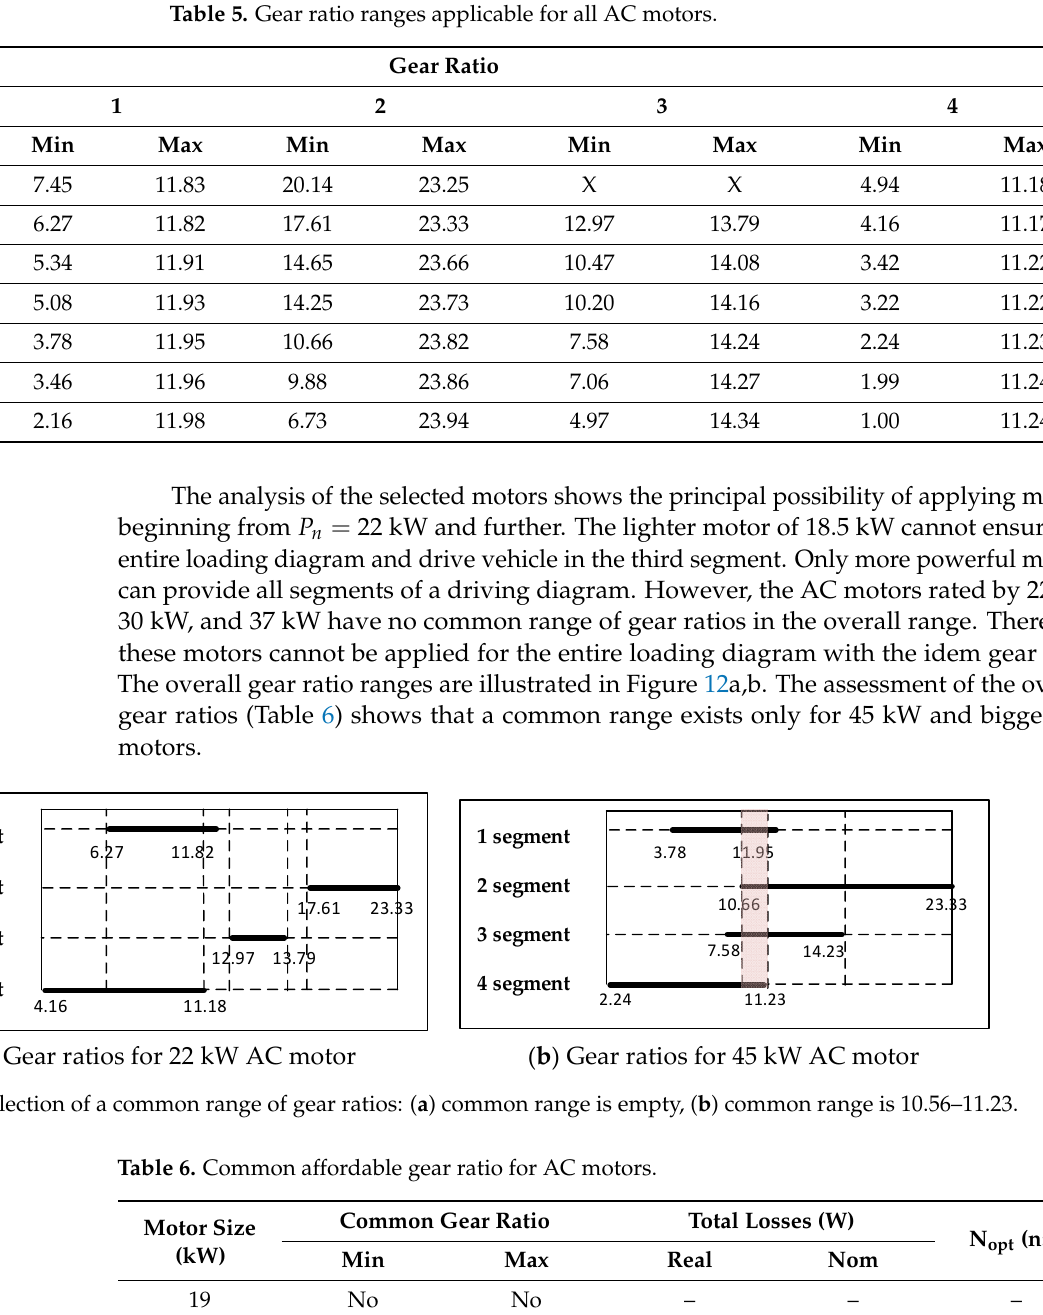
Table 5. Gear ratio ranges applicable for all AC motors.